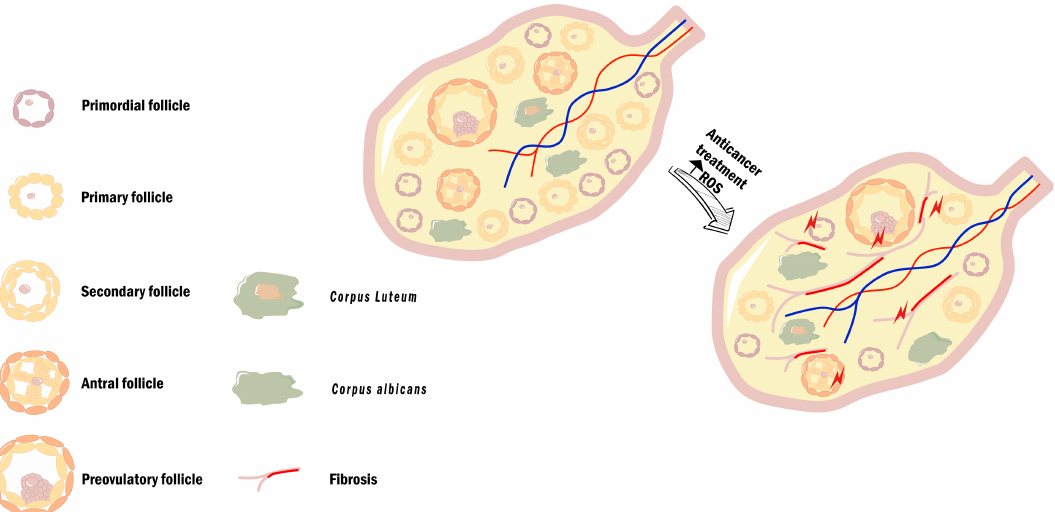
Figure 5. Ovarian tissue dysfunction after anticancer treatments. Increase in OS-derived from anti- cancer treatment, due to increased ROS production and impaired antioxidant response leads to the establishment of an oxidative microenvironment. In a post-treatment ovarian stroma, a depletion in the number of primordial and primary follicles and the presence of collagen deposition can be observed (fibrosis). The establishment of this compromised microenvironment impairs ovarian func- tion and is responsible for the fertility decline present in women submitted to anticancer treatments. Reactive oxygen species (ROS). Cisplatin and doxorubicin are two widely used chemotherapeutic drugs to treat several types of cancer, including those of the reproductive tract. Their ROS-mediated effects on fertility will now be